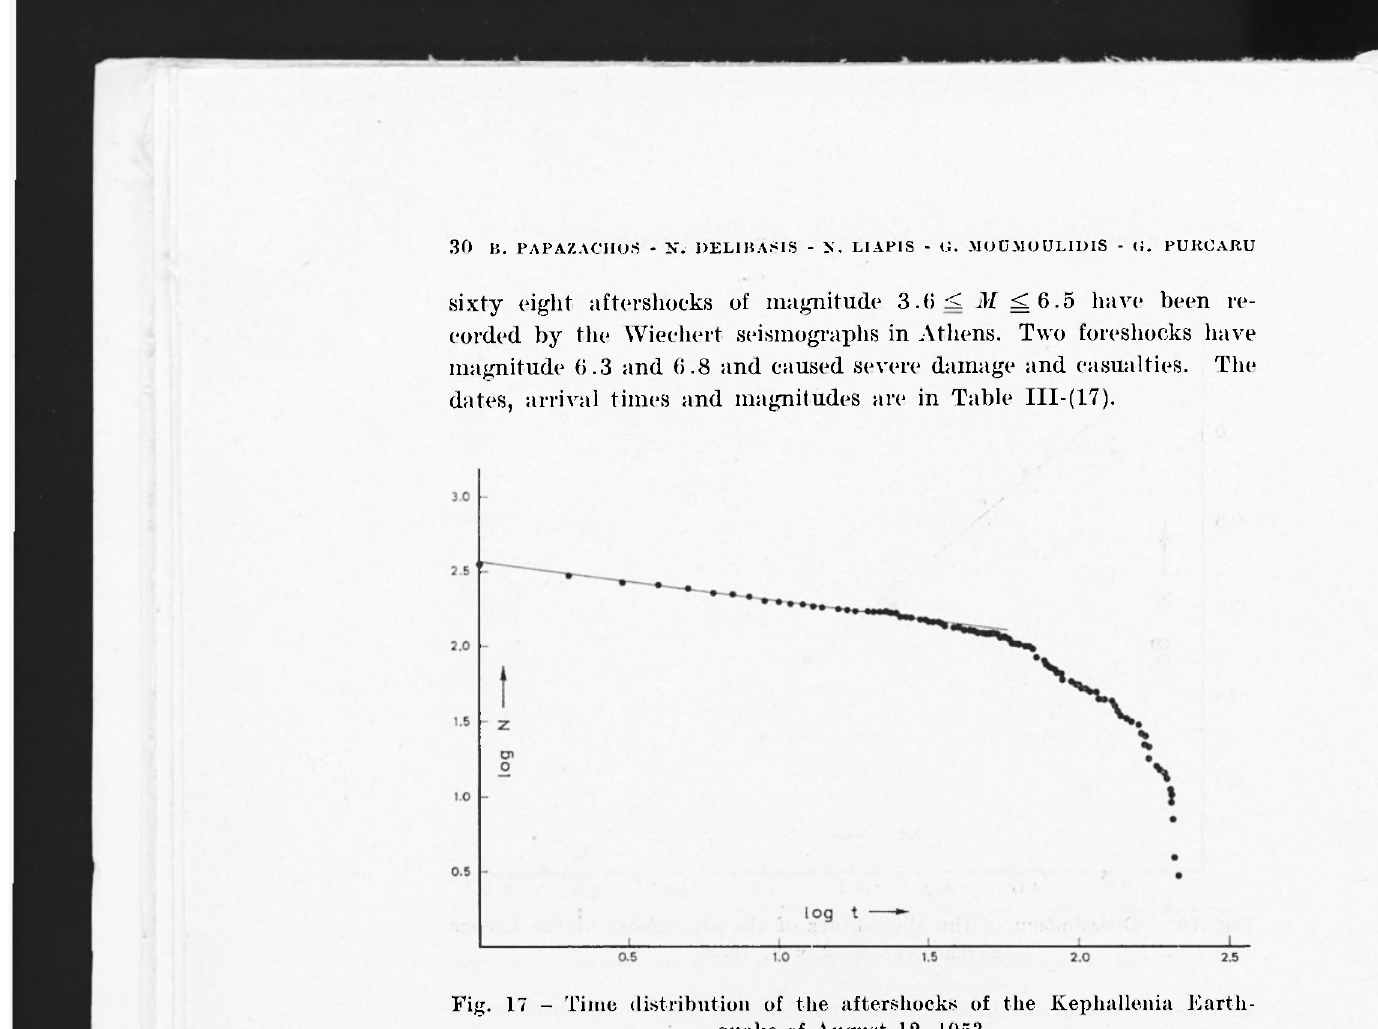
Fig. 17 - Time distribution of the aftershocks of the Kephallenia Earth- quake of August 12,